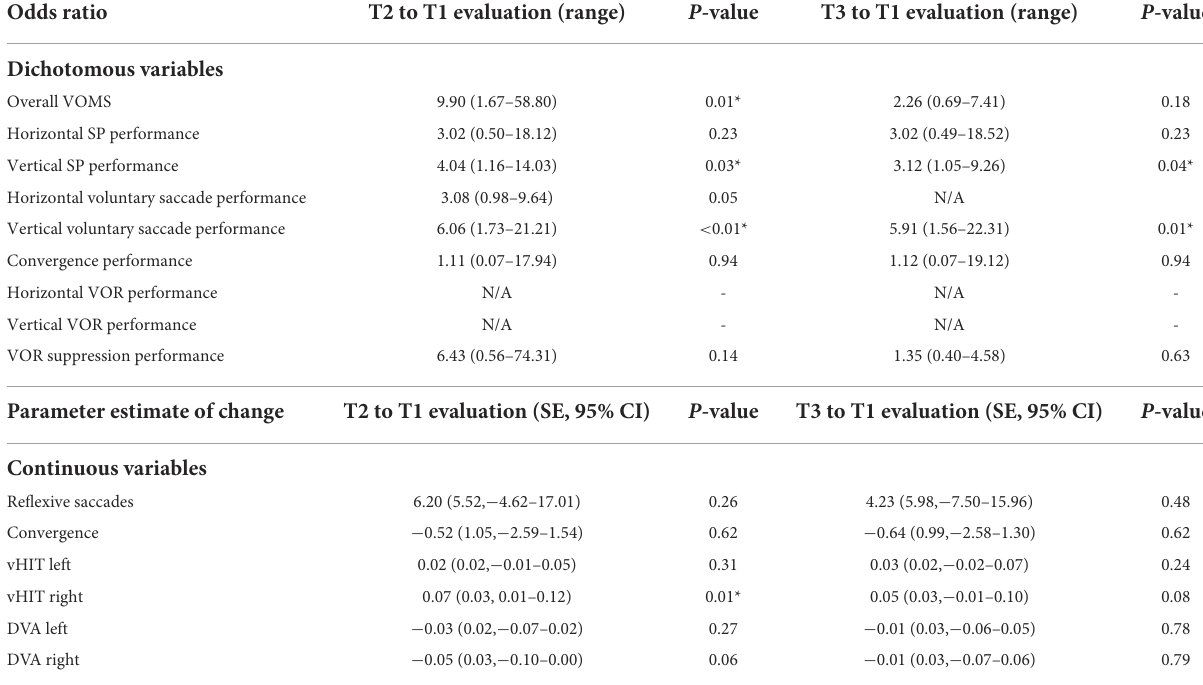
TABLE 5 Change values over time odd ratio (Binary) and parameter estimates (Continuous). Odds